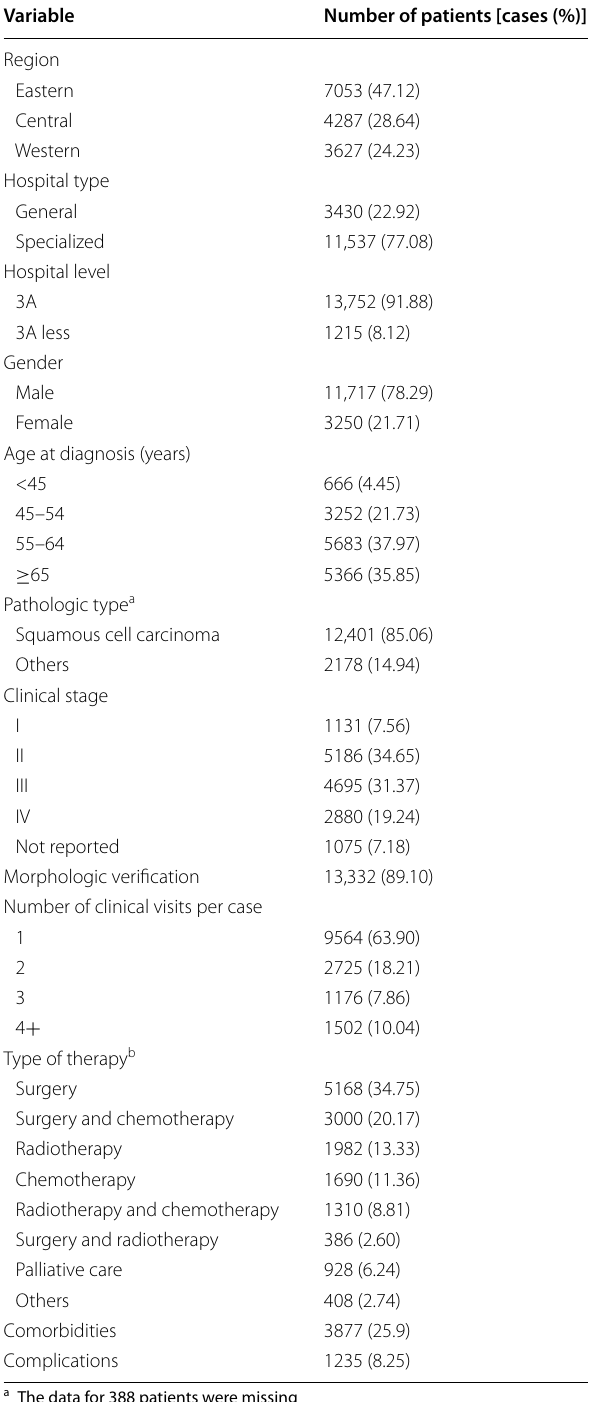
Table 2 Characteristics of the 14,967 selected esophageal cancer patients,